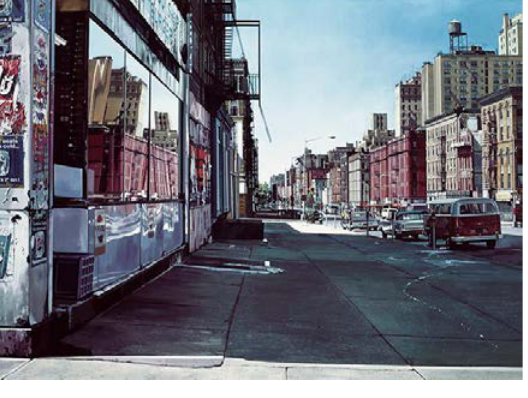
Fig. 21 Columbus Avenue at 90th Street - (1974) by Richard Estes